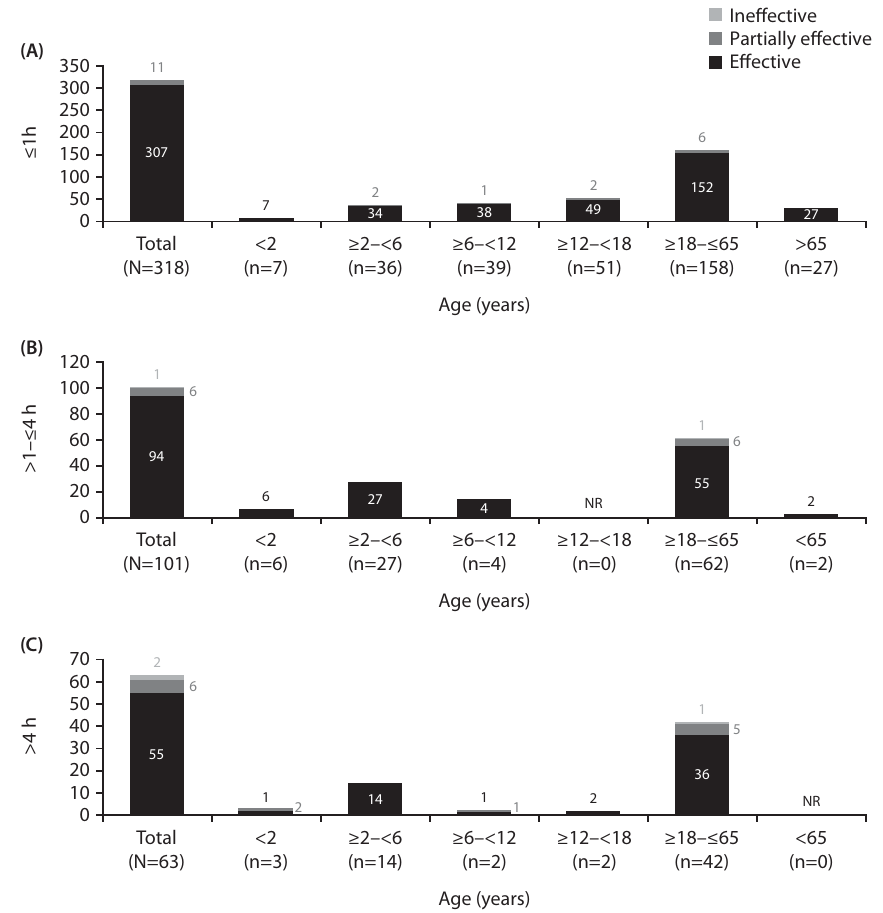
Fig. 3 Hemostatic response with rFVIIa (NovoSeven ® ) monotherapy by age and time to treatment in SMART-7 ™ . Bleeding episodes treated with recombinant factor VIIa monotherapy and with (1) valid ef fi cacy assessment, (2) no missing time for bleed start, (3) no missing time for any dose administration, and (4) valid time to fi rst treatment were included. NR, not